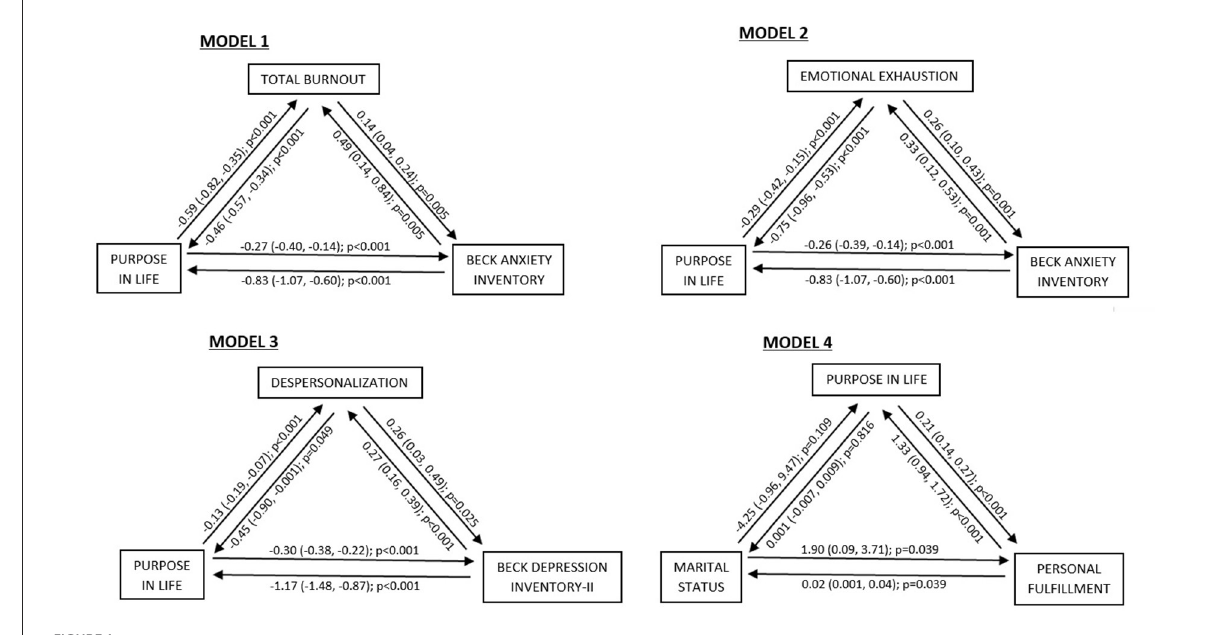
FIGURE1 Exploratory models of psychopathology in healthcare